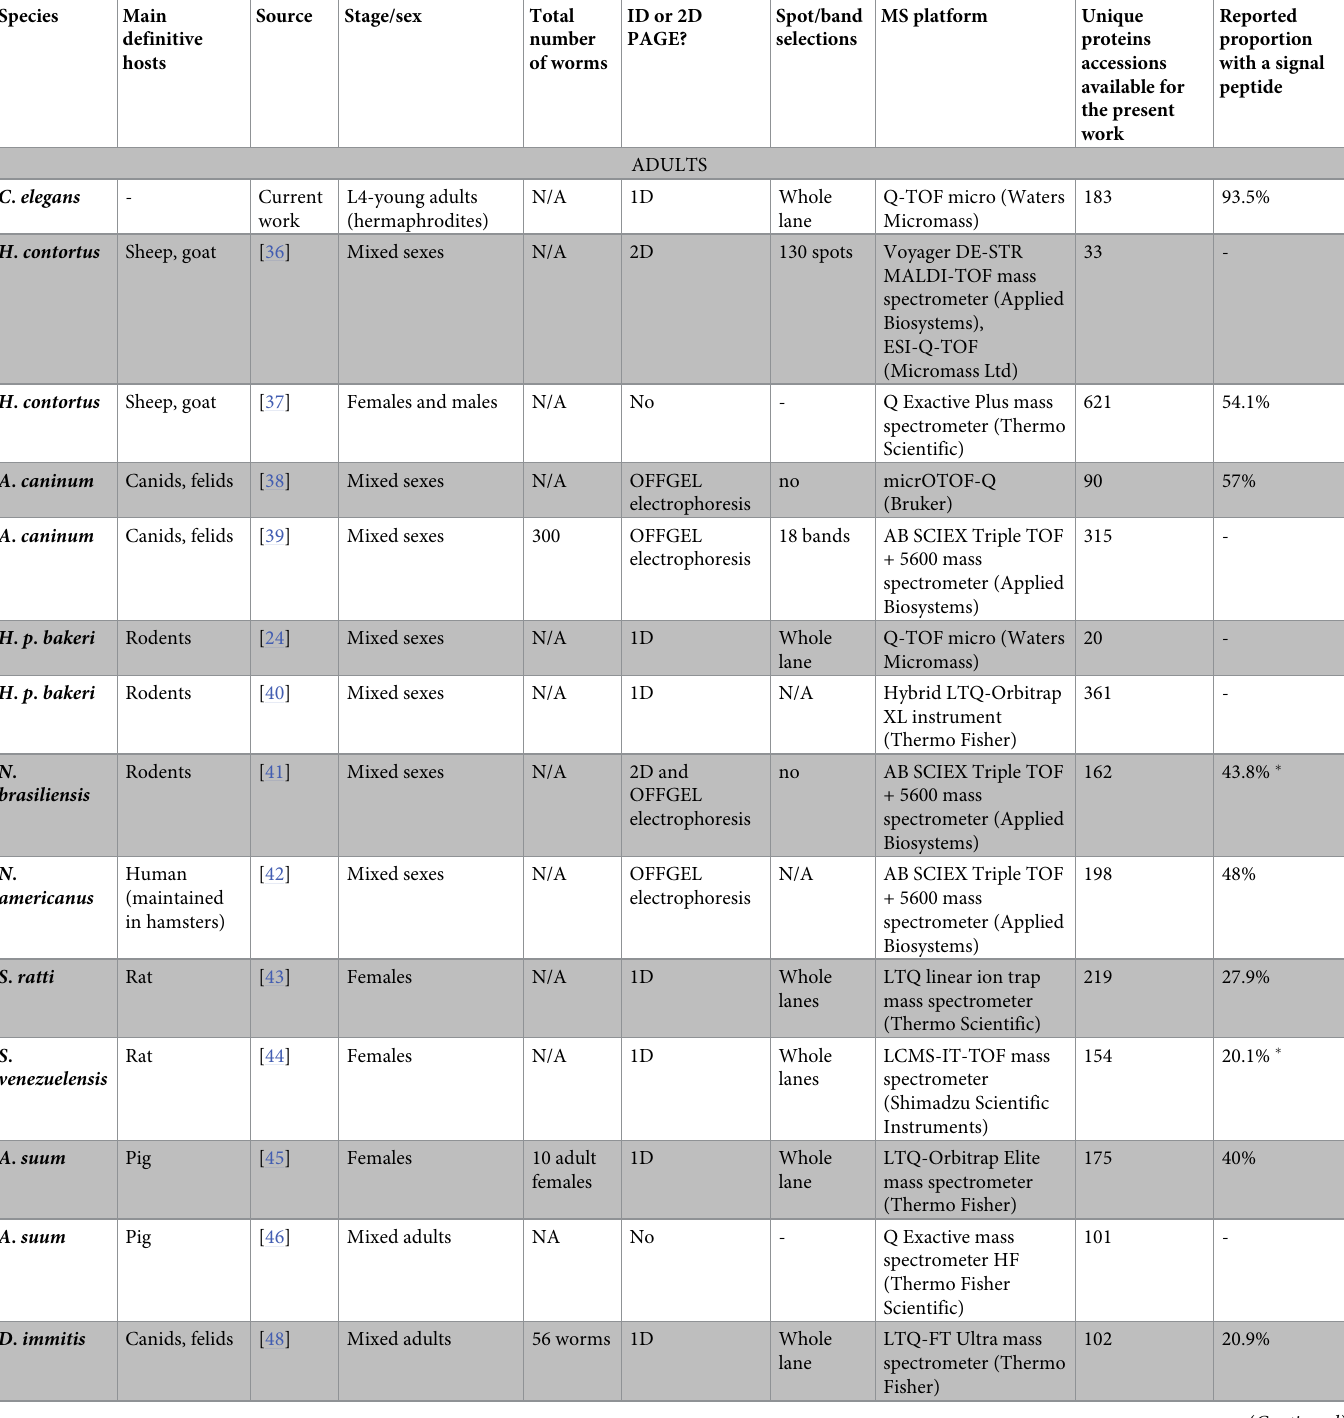
Table 1. Technical properties of the selected studies. Twenty-six studies, covering 20 parasite species, describing ESP analyzed in mass spectrometry experiments were considered. Methodological details are noted, as well as the number of unique proteins used from each